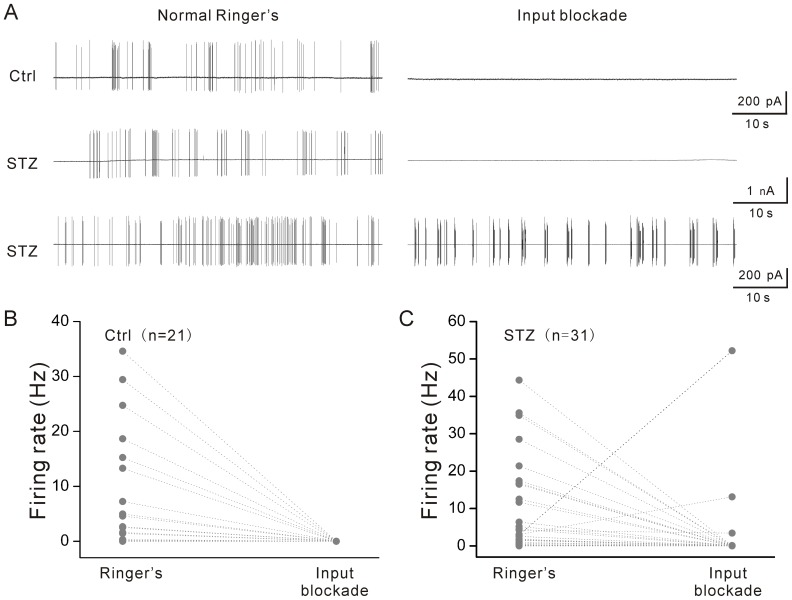
Effect of synaptic blockers on ON-type ganglion cell spontaneous activity.The cocktail of blockers contained (in μM): 50 L-AP4, 10 bicuculline, 10 strychnine, 50 D-AP5, and 10 CNQX. A. Representative traces show that spontaneous activity was completely eliminated in a control ON-type ganglion cell (upper panel) and a diabetic ON-type ganglion cell (middle panel), but was maintained to some extent in another diabetic ON-type ganglion cell (lower panel). Summarized data show that spontaneous firing rate of each ON-type cell was recorded before and after application of the synaptic blockers in control (B) and diabetic retinas (C). Grey circles show firing rate of each cell.